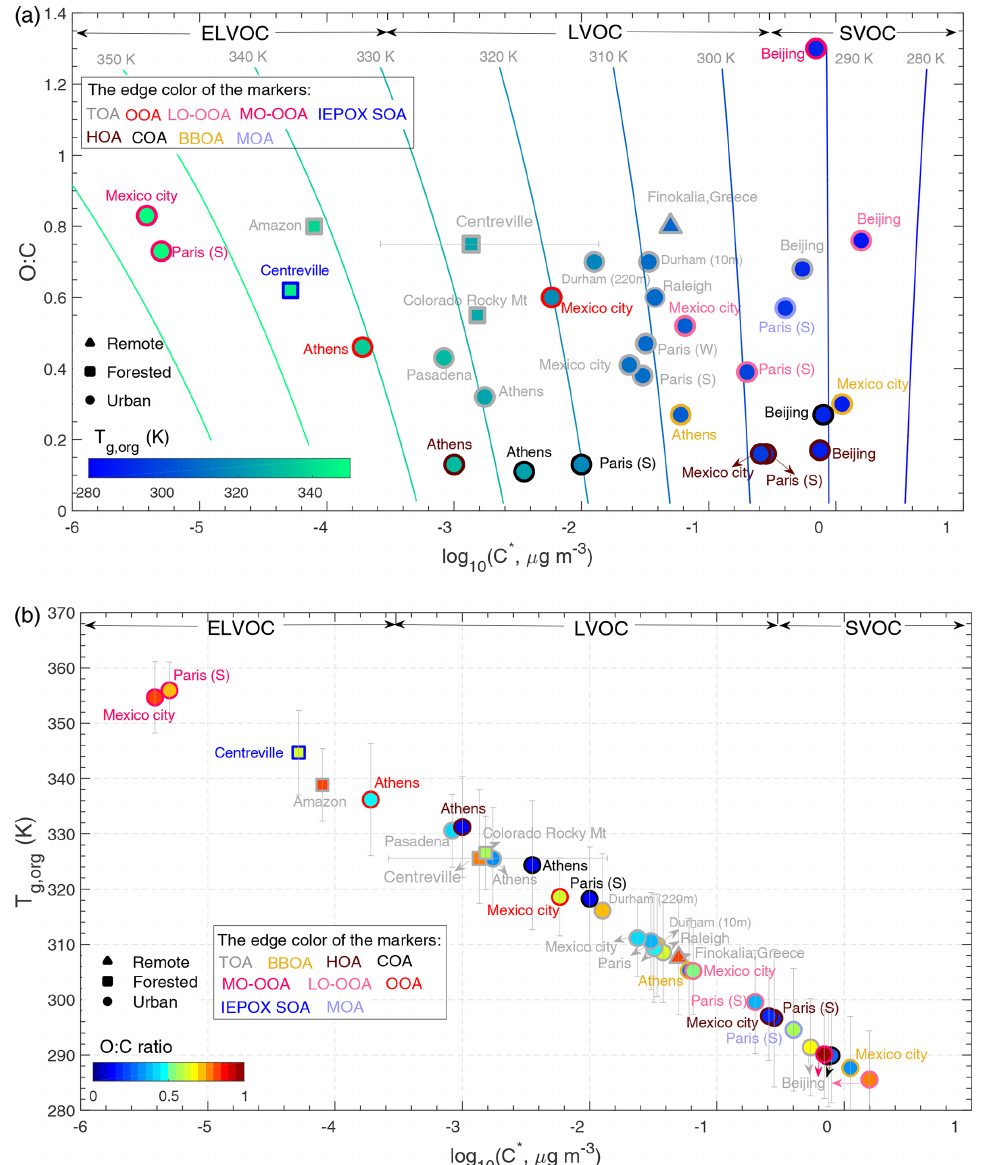
Figure 4. Predicted glass transition temperatures of organic aerosols under dry conditions ( T g , org ) at 11 sites. The fill color of the markers represents T g , org (a) or the O : C ratio (b) . The marker edge color indicates the OA components identified via PMF of the AMS mass spectra. The isopleths in (a) correspond to T g calculated using Eq. (1) with C ∗ and O : C defined in the 2D-VBS. The vertical error bars correspond to uncertainties in T g , org considering parameterization uncertainties and error propagation. The horizontal error bars for the Centreville site correspond to the upper and lower limits of the average log 10 (C ∗ ) calculated from different volatility distributions measured during the SOAS campaign (Hu et al., 2016; Saha et al., 2017; Stark et al.,